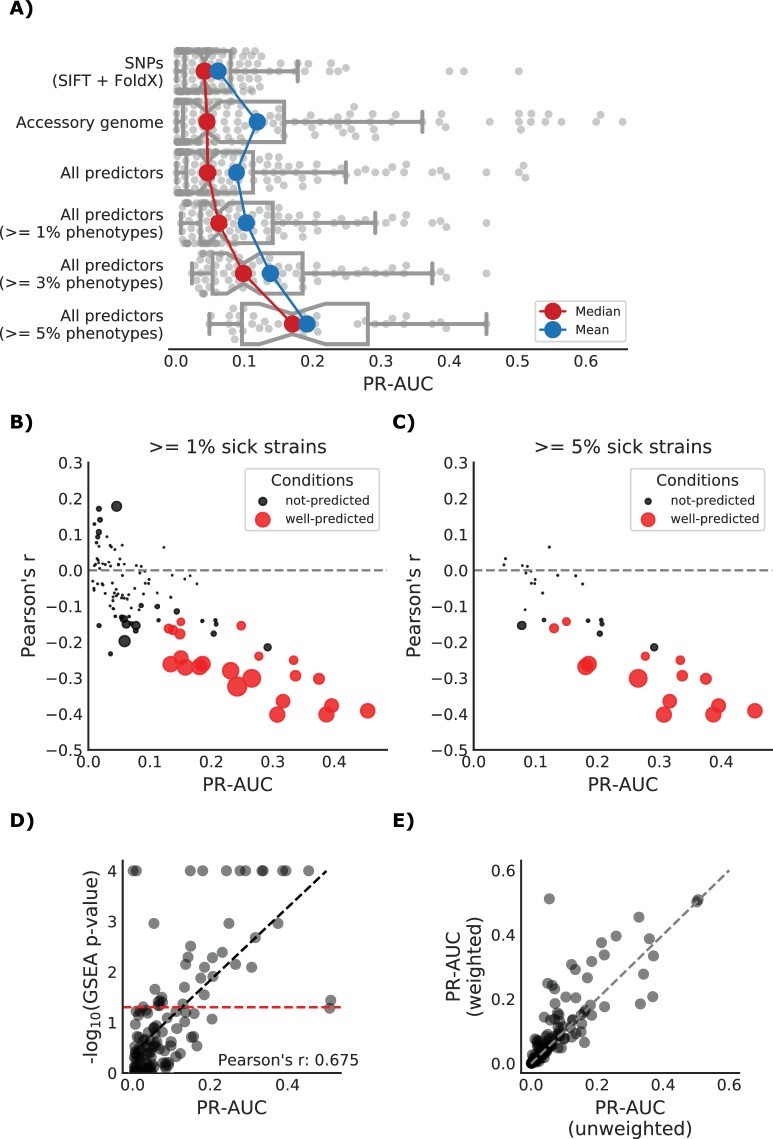
Detailed view of the predicted growth score and its properties.(A) Influence of the different predictors of the impact of mutations on each condition PR-AUC. ‘SNPs’ indicates single nucleotide variants only, ‘Accessory genome’ gene presence-absence patterns, ‘All predictors’ the combination of both, plus stop codon substitutions. (B–C) Proportion of well-predicted conditions (PR-AUC >= 0.1 and Pearson’s FDR-corrected p-value<=0.01) over total conditions with at least 1% and 5% sick strains. Marker’s size is proportional to the −log10 of the FDR-corrected p-value. (E) Conditions with higher predictive power (measured as PR-AUC) also have an enrichment of sick strains at the top of the predicted score, as measured by the Gene Set Enrichment Analysis (GSEA); sick strains are used as ‘gene sets’. A pseudocount of 10−4 has been added to the GSEA p-values. (F) Prediction performance improves when using the weighting scheme to account for conservation of gene essentiality, especially for well-predicted conditions.